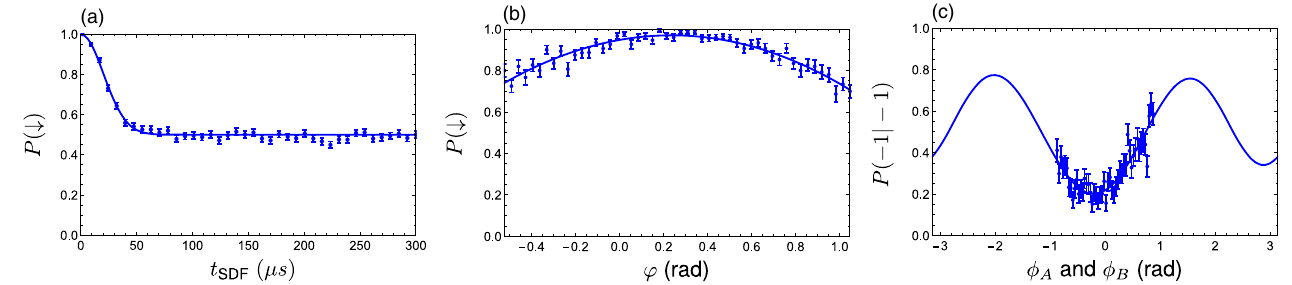
FIG. 5. Calibrations. Panel (a) shows a calibrated SDF pulse applied to a ground-state cooled ion and a fit to the expected behavior 1 þ e − 2 ð ct SDF Þ 2 Þ . From this fit, we extract the proportionality constant c between displacement size and t P ð ↓ Þ ¼ 1 2 ð all analytic calculations of expected measurement results. Panel (b) shows the phase matching between addressing transition 2 with single frequency or with a bichromatic pulse. The sequence consists of a single π = 2 pulse followed by a SDF pulse, here with t 200 μ s. Whenever the π = 2 pulse phase φ is matched to the SDF, no superposition will be created; instead, the full wave packet is SDF ¼ displaced, and therefore, P ð ↓ Þ ≡ 1 for any SDF duration. Finally, we need to calibrate the phase of the R 1 ð ϕ Þ pulse using an experimental calibration, as shown in panel (c). We use a sequence of two modular measurements with the same duration and opposite SDF directions in order to be able to observe a signal. We sweep both phases ϕ A and ϕ B simultaneously and read out the relevant